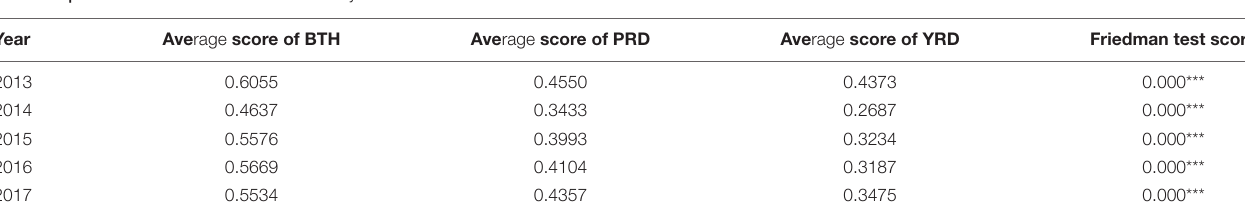
The data in the table are calculated with SPSS Statistics 25 software (IBM Corporation, Armonk, NY, United States). ***Significant confidence interval of 0.05 (two-tailed